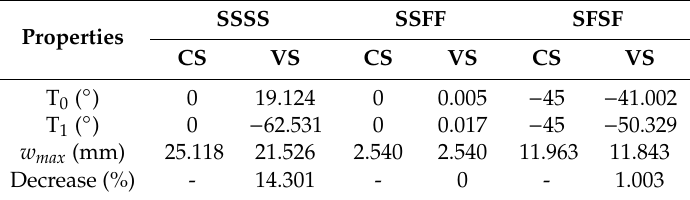
Table 10. Optimum angles for a single layer VS plate for CCCC, CCFF, and CFCF boundary conditions.